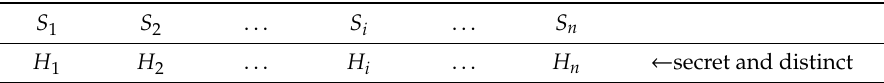
Table 2. Sets of security class and superkey.